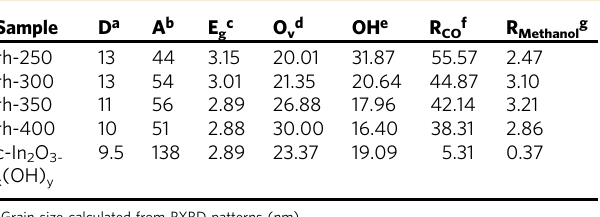
Table 1 Summary of properties of various In 2 O 3-x (OH) y samples Sample